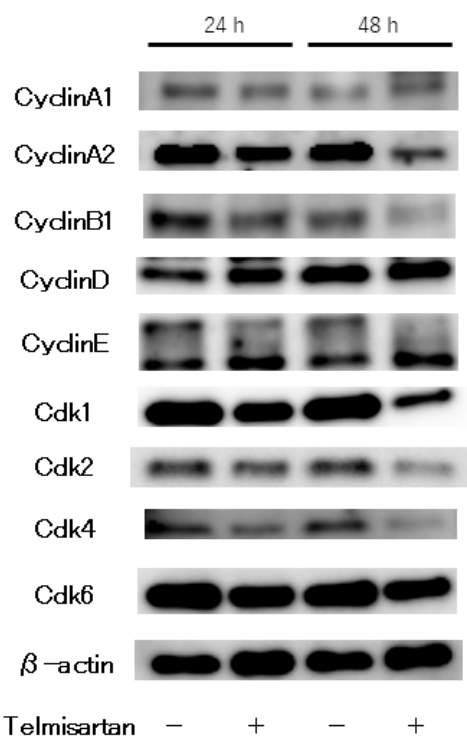
Figure 3. Western blot analysis of cell-cycle regulatory proteins in KYSE180 cells treated with 50 µM telmisartan. Expression levels of Cyclin A2, Cyclin B1, CDK1, CDK2, CDK4 were decreased in treated cells.